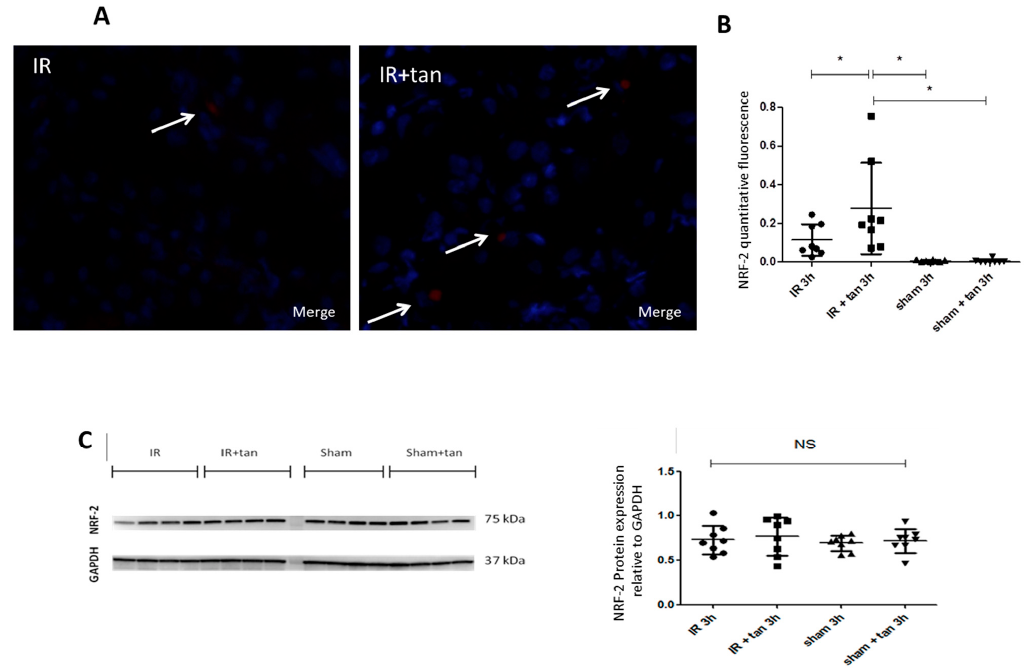
Figure 7. Tannic acid induced Nuclear Factor erythroid-2-Related factor 2 (NRF2) expression in kidneys. Protein expression of NRF2 determined by immunostaining (40X; A – B ) or by western blot ( C ). Quantification of fluorescence intensity for NRF2 immunostaining ( B ). n = 8, values are mean ± SD, * p < 0,05.